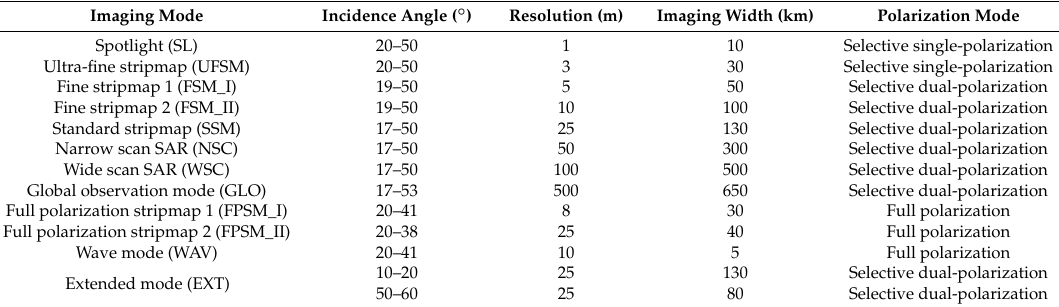
Table 1. Imaging modes of the GF-3